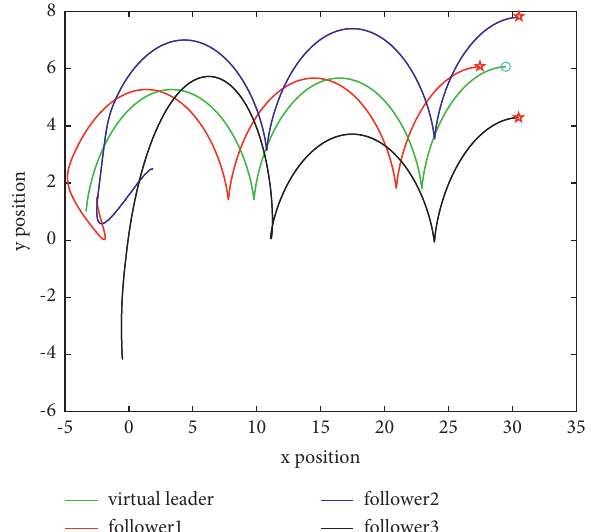
Figure 13: The formation trajectories of three followers and the virtual leader in Case steady state of the estimation error of Q-LESO is smaller than that of LESO as can be seen in the locally enlarged plot.